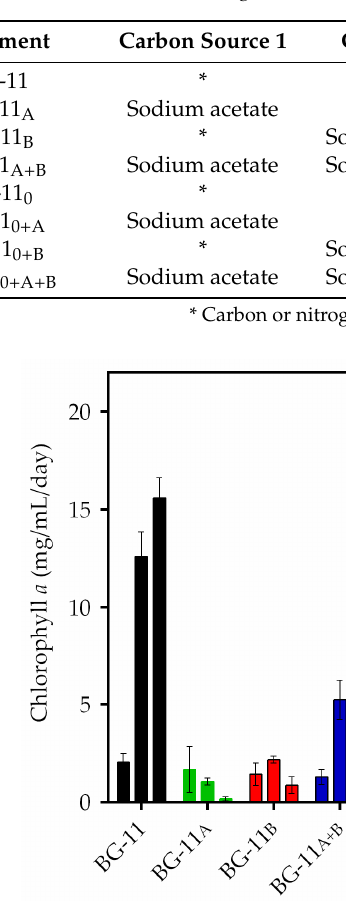
Table 1. Treatments of Stigeoclonium sp. B23 in di ff erent BG-11 media.